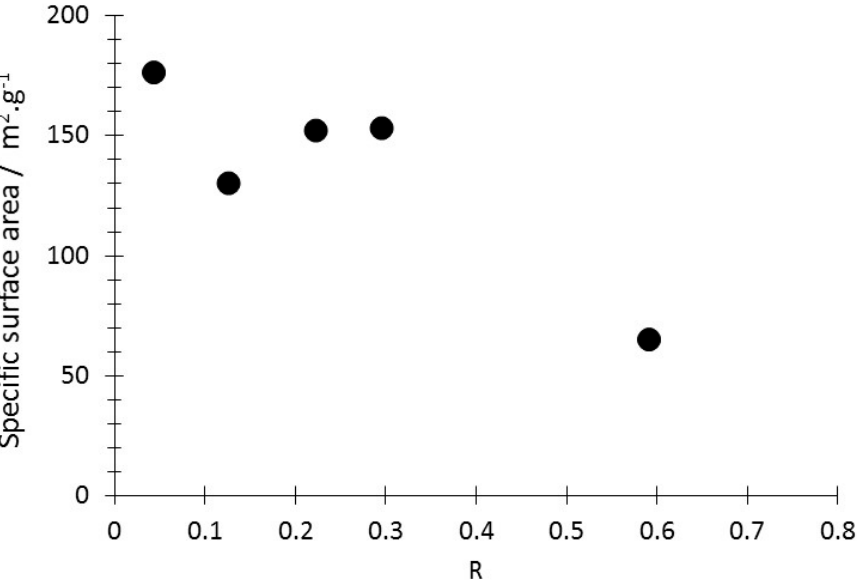
Figure 4. Trend for the specific surface area of the powders as a function of R parameter for materials obtained from LPM-2.